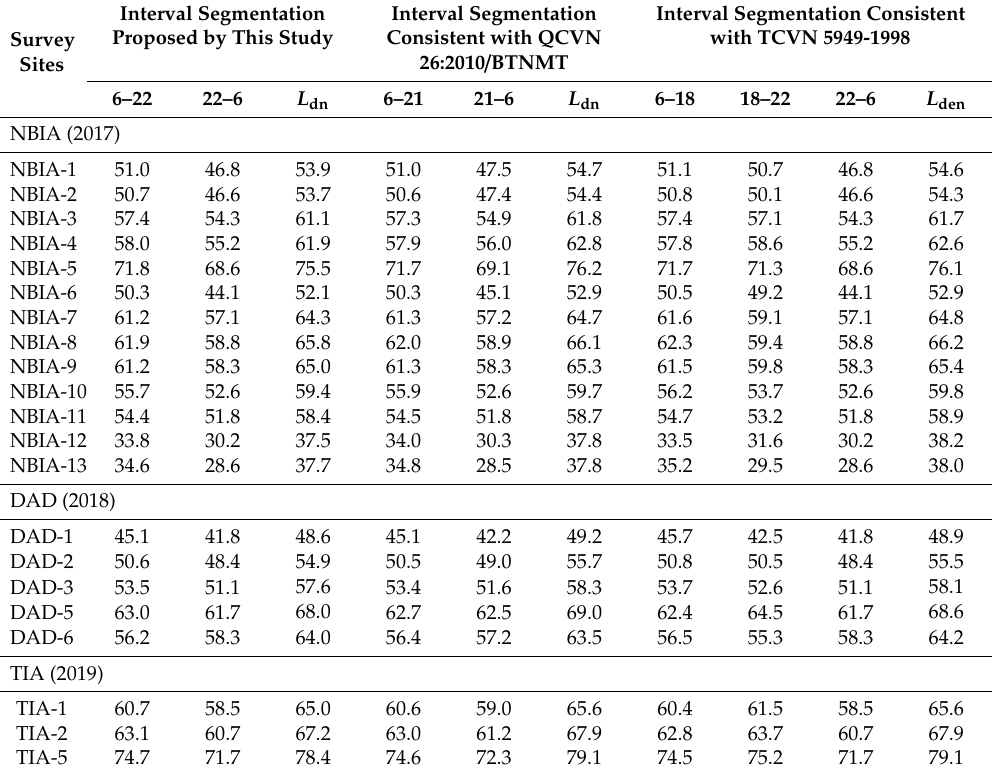
Table 10. L den , L dn , and L day L night noise indicator values when di ff erent time interval segmentation was